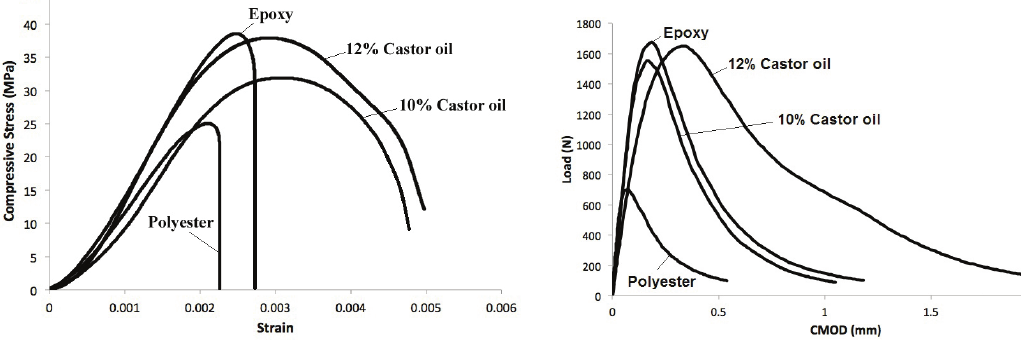
Figure 1. Typical compressive stress vs. strain of castor oil and synthetic polymer mortars.